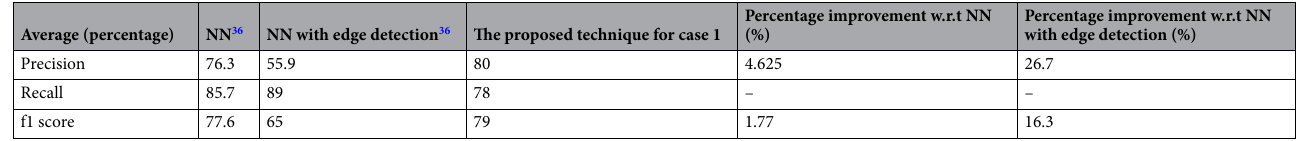
Table 9. Percentage improvement of proposed case 1 w.r.t base cases.